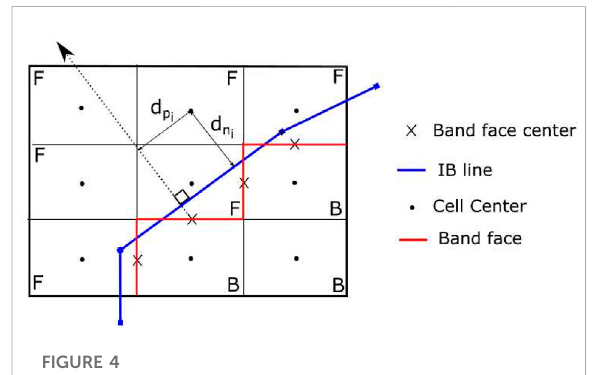
FIGURE 4 Stencil for the determination of the interpolation point.